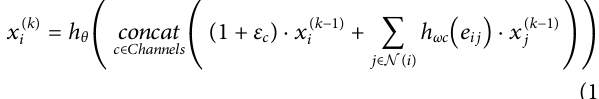
Frontiers in Pharmacology |